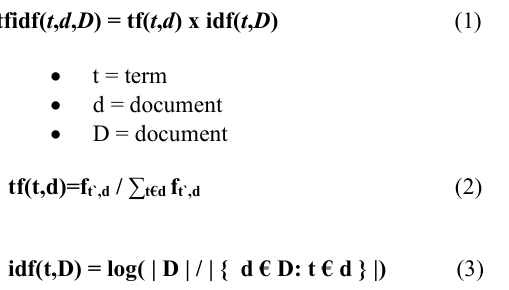
Fig. 2. shows the flowchart of the preprocessing method.